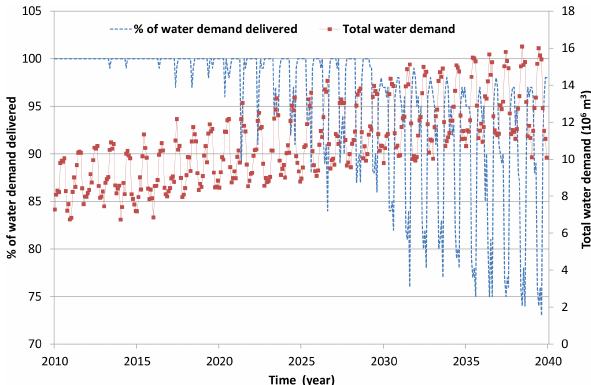
Figure 3. Water demand projection and monthly percentage of wa- ter demand delivered over the planning horizon for the